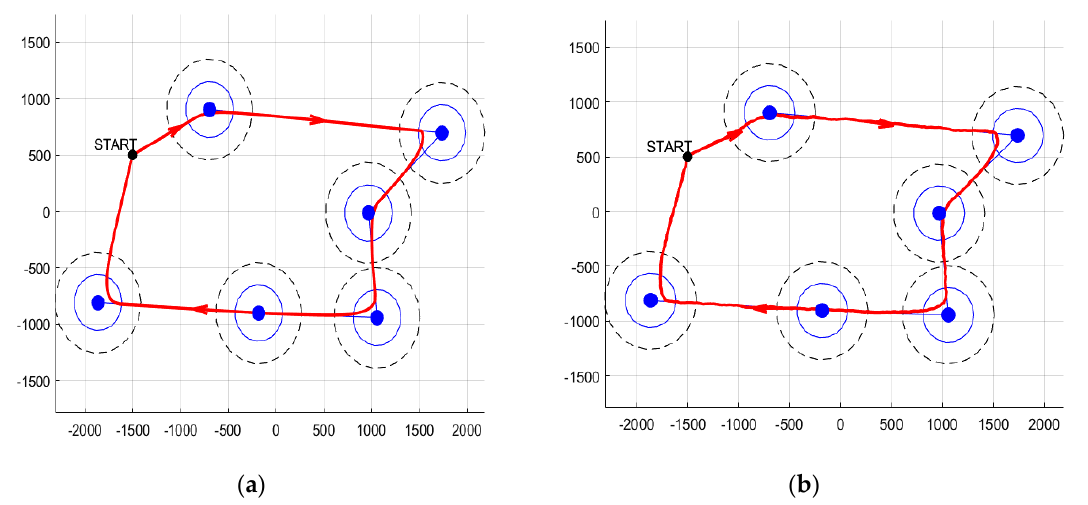
Figure 7. Illustration of segment tracking: ( a ) nominal case and ( b ) with wind disturbances.